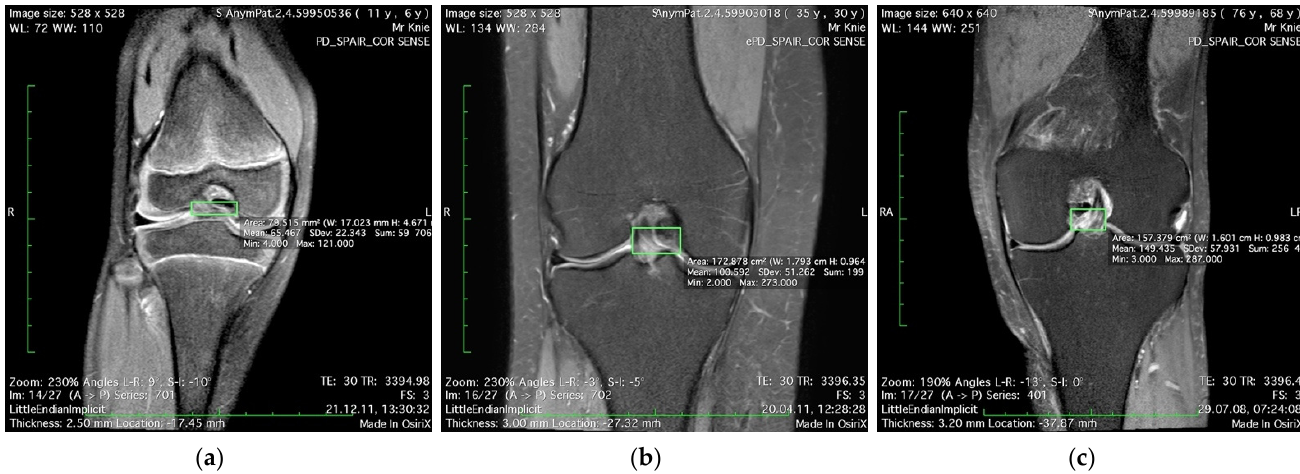
Figure 1. Demonstration of the application of a visual guide (green box) in the assisted semi-quantitative evaluation of the IN. ( a ) A-shaped notch of a 6-year-old patient. Note the difference between NWp and NWj (NWp < NWj). ( b ) Inverse U-shaped notch of a 30-year-old patient. Note the similar width of NWp and NWj (NWp = NWj). ( c ) Ω -shaped notch of a 68-year-old patient. Note the difference between NWp and NWj (NWp > NWj).